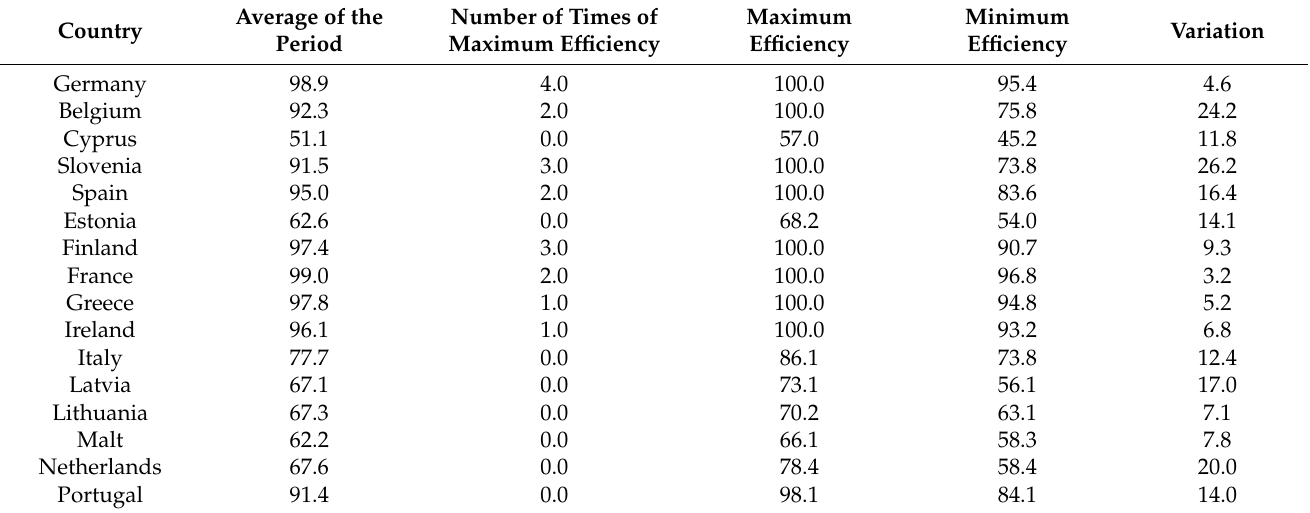
Table 4. Summary of efficiency indicators for the period